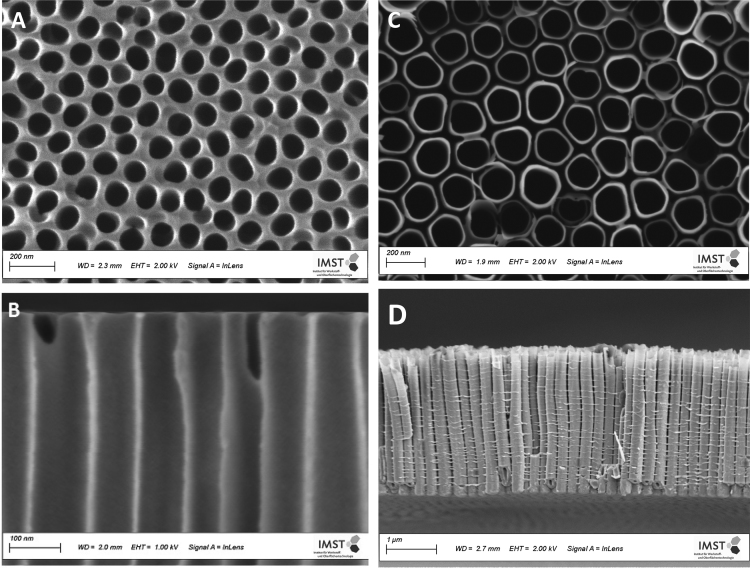
(A) SEM micrograph of unmodified AAO pores (top view), (B) SEM micrograph of uncoated AAO pores (cross section), (C) SEM micrograph of unmodified TiO2-NT pores (top view), (D) SEM micrograph of uncoated TiO2-NT pores (cross section).